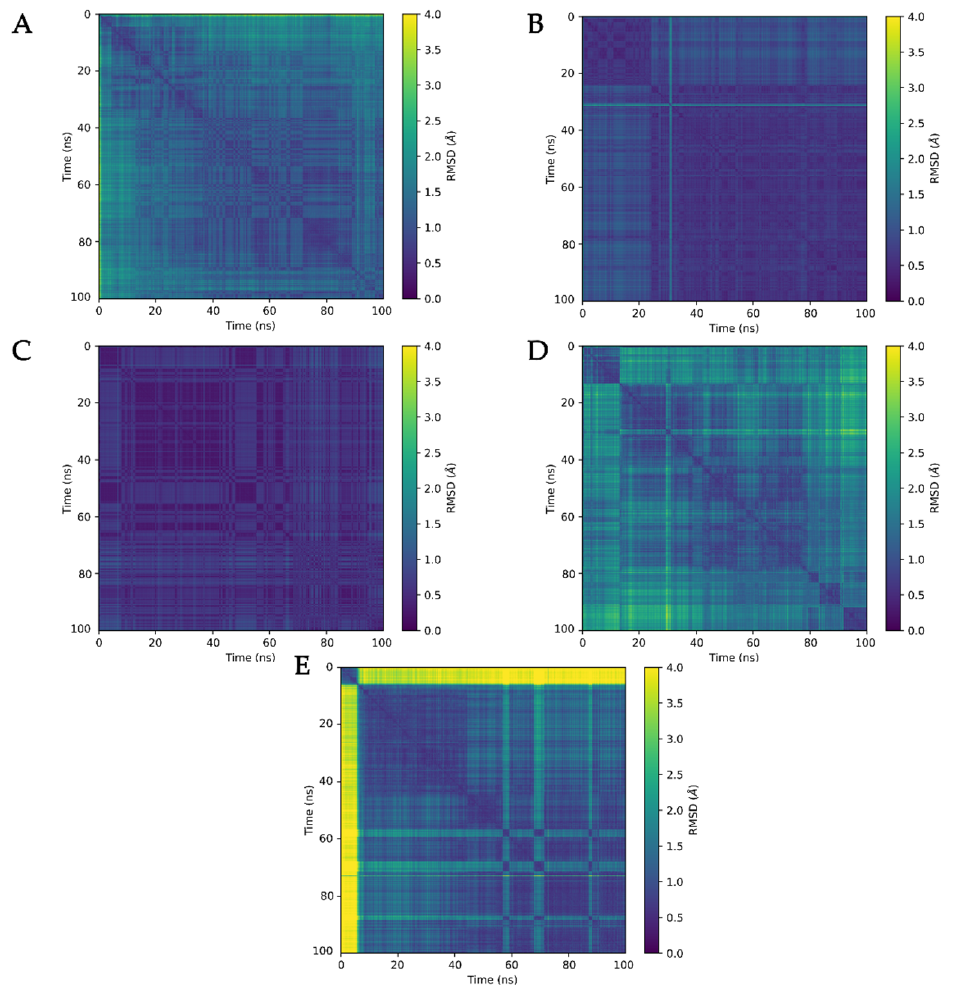
Figure 7. Ligand stabilities in MD simulations analyzed using pairwise RMSD calculations, for astemizole ( A ), clofilium ( B ), imipramine ( C ), MK-499 ( D ), and quinidine ( E ). Large color differences next to the diagonal line indicate major conformational changes compared to the neighboring